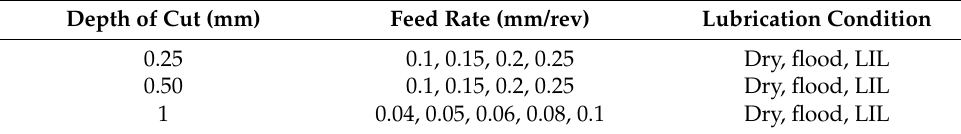
Table 1. Combination of cutting parameters for the experimental tests.